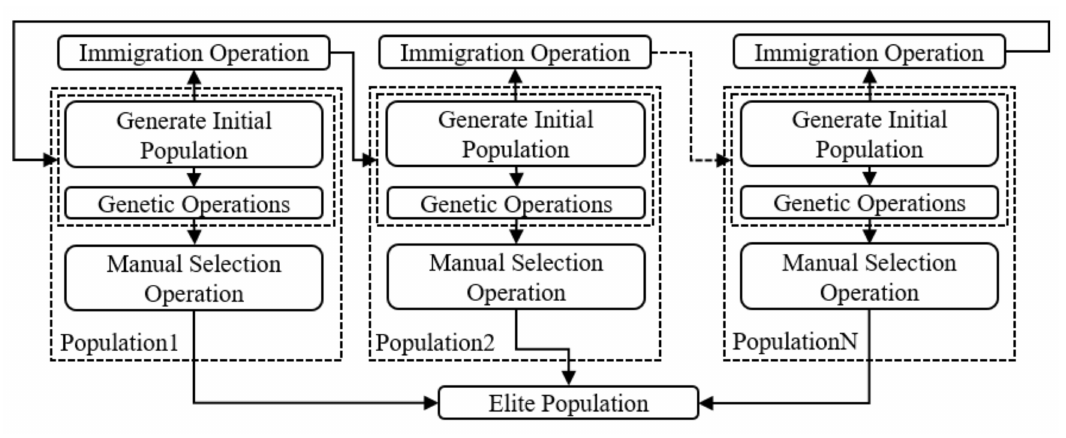
Figure 3. Diagram of the immigration